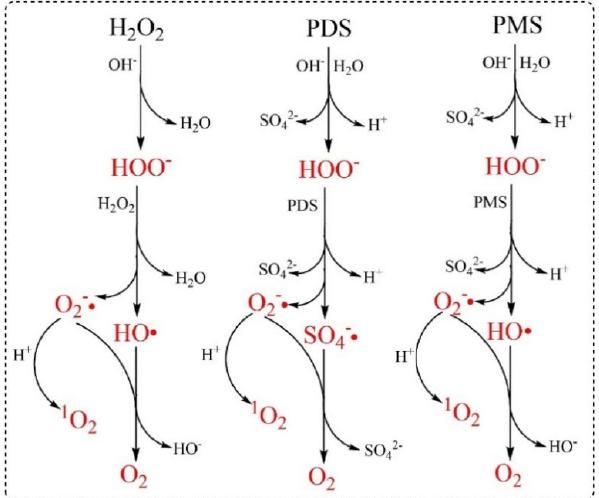
Figure 6. The dissociation of oxidants by the addition of carbonate species and the subsequent gen- eration of ROS. Reprinted with permission from [24]. generation of ROS. Reprinted with permission from